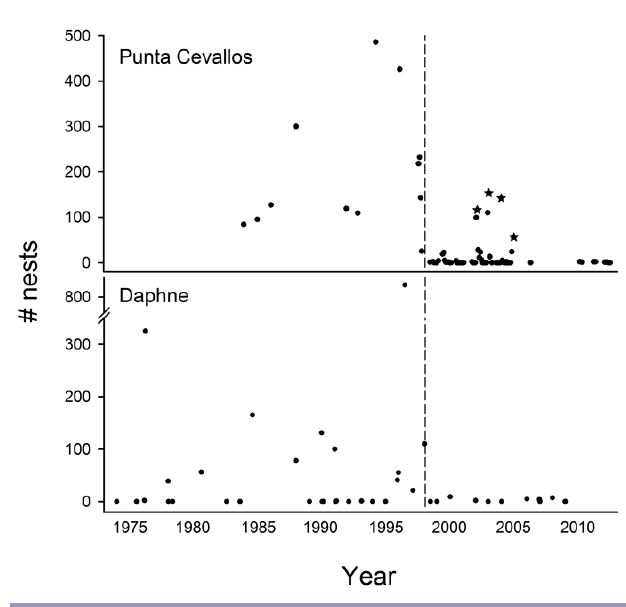
Fig. 1 . Numbers of active nests of Blue-footed Boobies ( Sula nebouxii excisa ) at Punta Cevallos, Española (D. J. Anderson, unpubublished data ) and Daphne Major (P. R. Grant and B. R. Grant, unpubublished data ). Vertical line indicates March 1 1997, middle of the 1997-1998 El Niño Southern Oscillation event, and roughly the timing of declining sardine abundance in the Peruvian upwelling. Stars indicate the peak of a rapid increase in number of nests followed by a mass breeding failure in the subsequent four